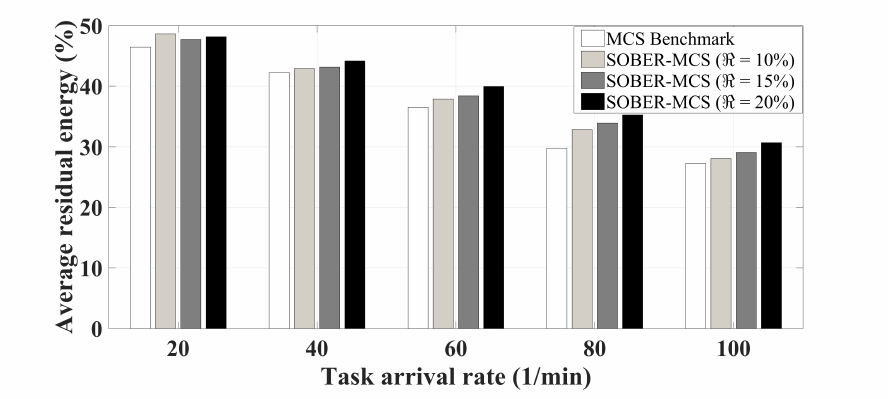
Figure 11. Average residual energy under SOBER-MCS with various residual battery